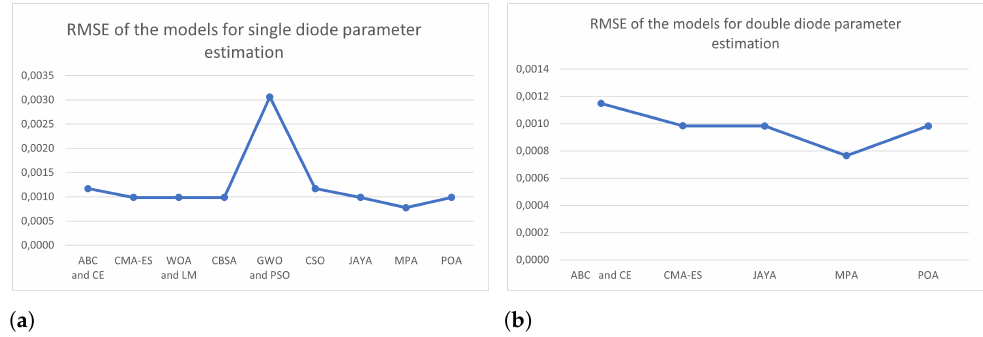
Figure 9. RMSE of the different models for parameter estimation. ( a ) Single-diode; ( b )